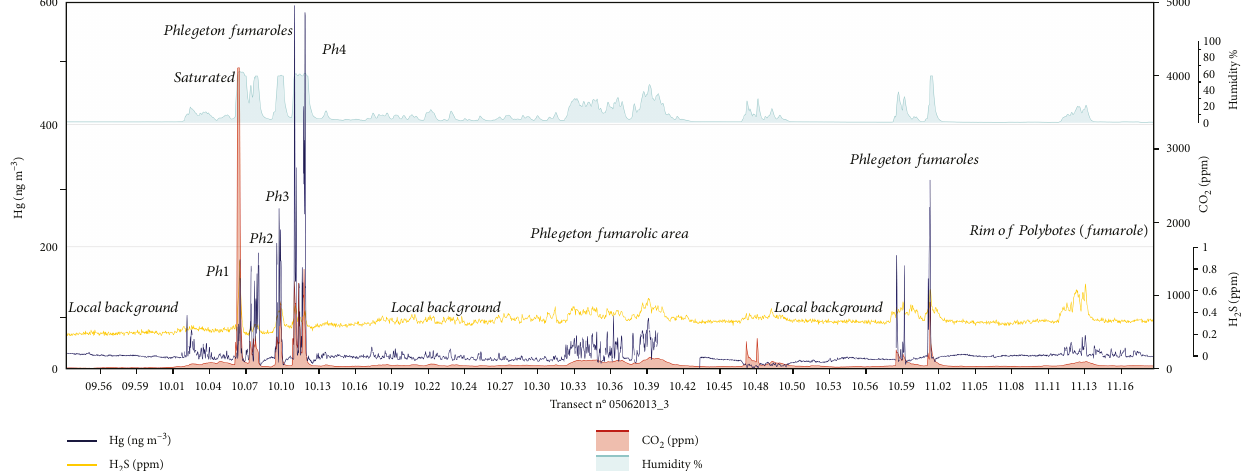
Figure 4: Concentrations in the atmosphere of H main fumaroles